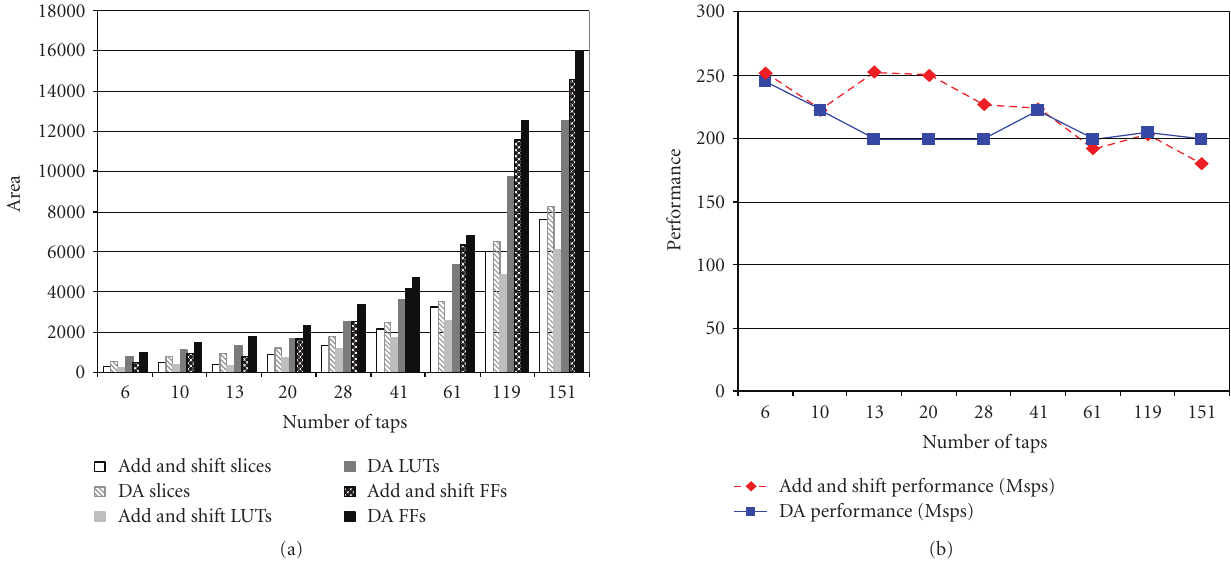
Figure 10: (a) Resource utilization in terms of # of slices, flip flops, and LUTs for various filters using add and shift method (this paper). (b) Performance implementation results (Msps) for various filters using add and shift method (this paper) versus parallel distributed